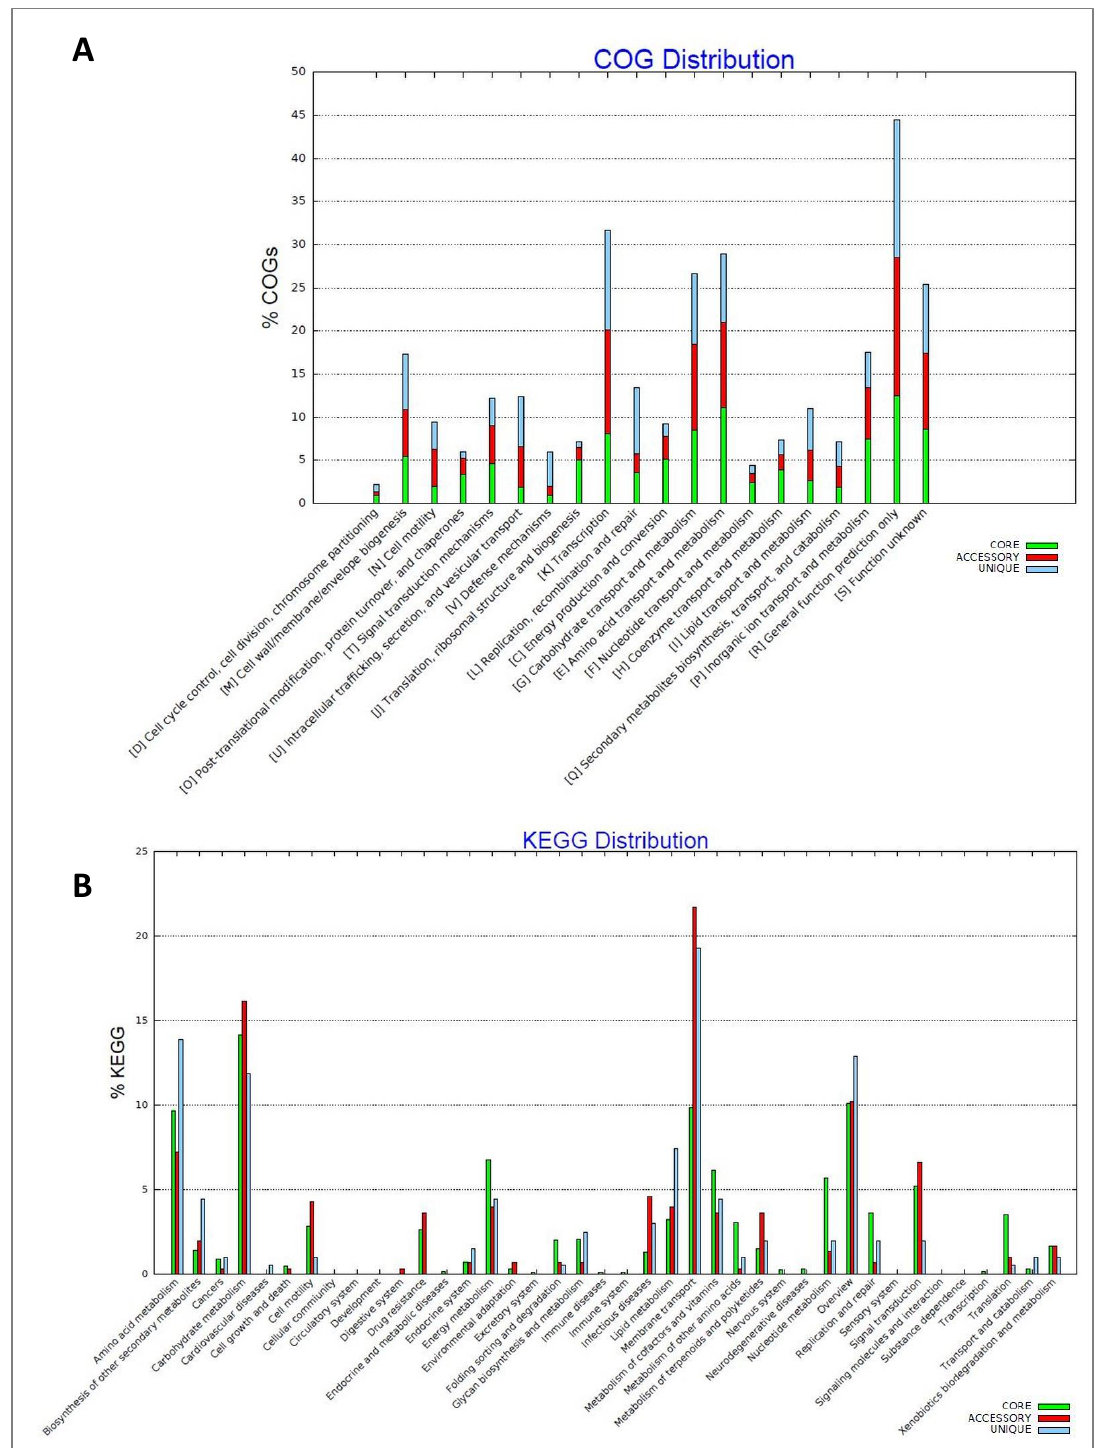
Figure 3. Distribution of orthologous groups of proteins (COGs) across the analyzed Pantoea vagans strains pan- and core-genome ( A ). Distribution KEGG pathways across the analyzed P. vagans strains pan- and core-genome ( B